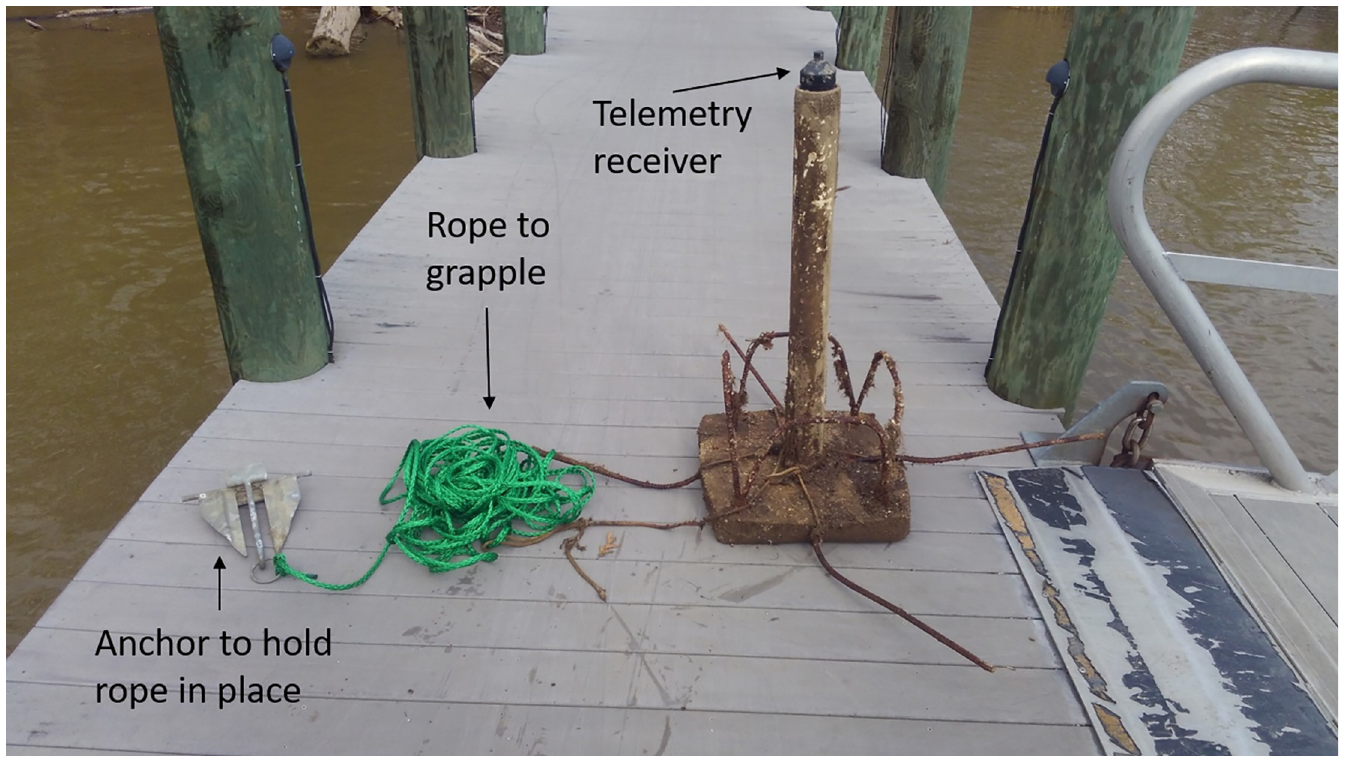
Fig 3. Setup to reduce movements of receives in the Vemco Positioning System